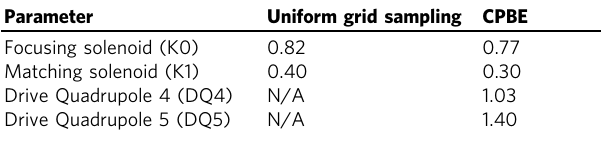
Table 1 Trained hyperparameter length scales